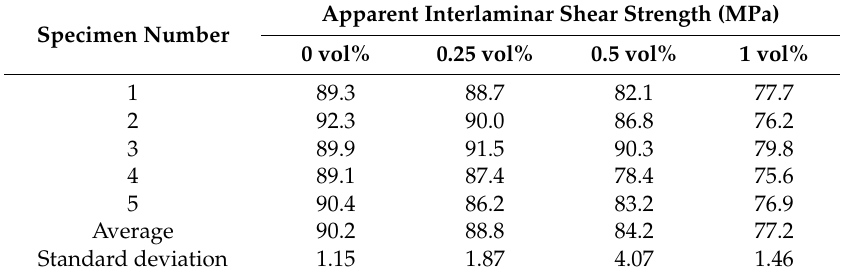
Table 3. Apparent interlaminar shear strength of unpinned Cf/Al composites and z-pinned Cf/Al composites using stainless steel pins with diameters of 0.3 mm measured by short-beam shear test.